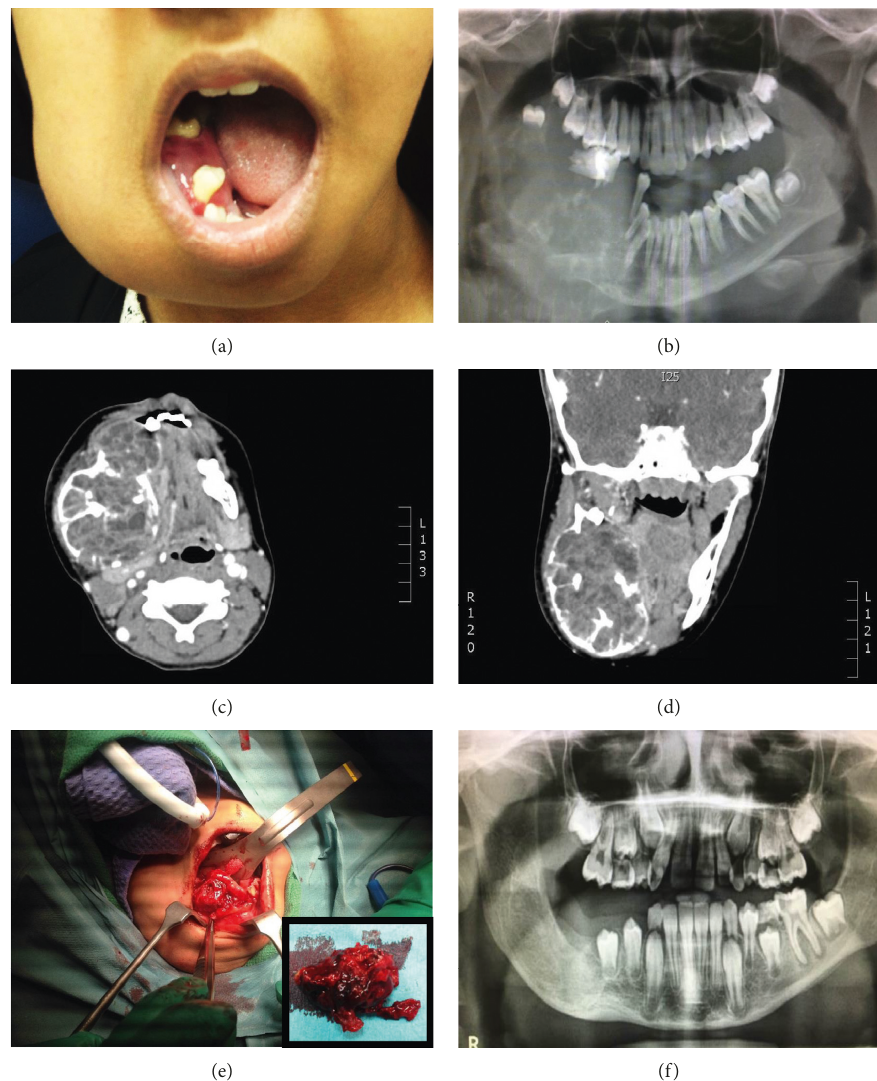
Figure 1: (a) A 12-year-old girl with right mandibular and neck mass displacing teeth all the way. (b) Panorex view that shows massive destruction of half of her mandible with extension into condyle, neck, and medial of right of mandible. (c) Axial and (d) coronal CTscan of neck and soft tissue that shows multiple septations along with wall enhancement within the lesion. (e) Large soft tissue tumor was visible intraoperatively. Gross examination of large hemorrhagic soft tissue mass measures 6 × 6 × 3cm (inset). (f) Postoperative panorex view of the patient which shows complete healing of her bony defect with significant resolution in her unique facial deformity that resembles